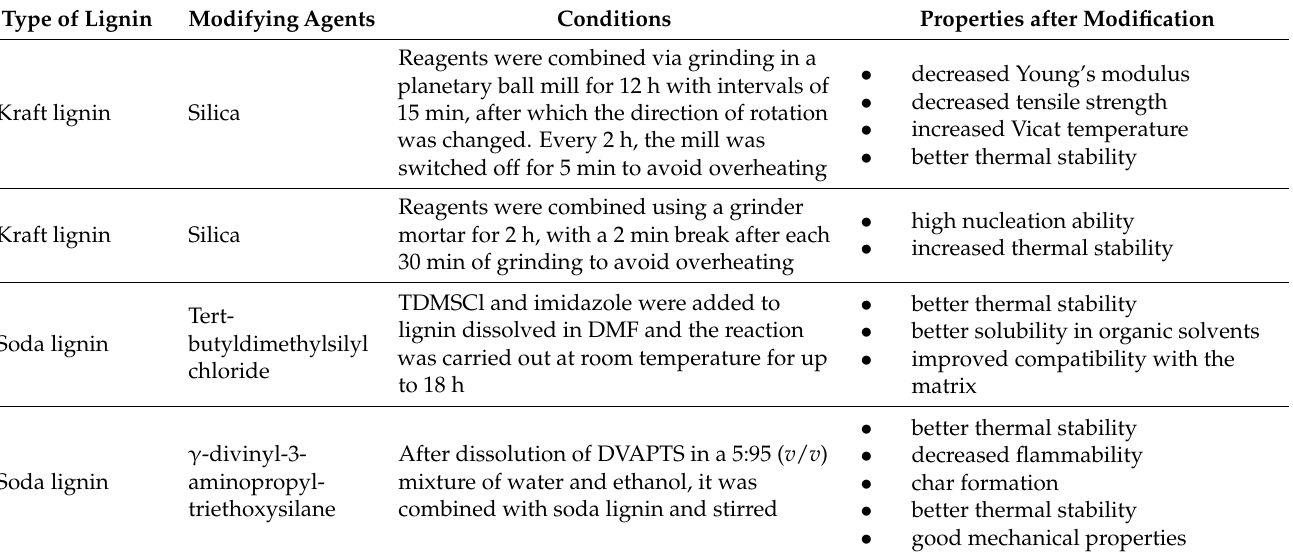
Table 11. Table summarizing the silylation reaction of